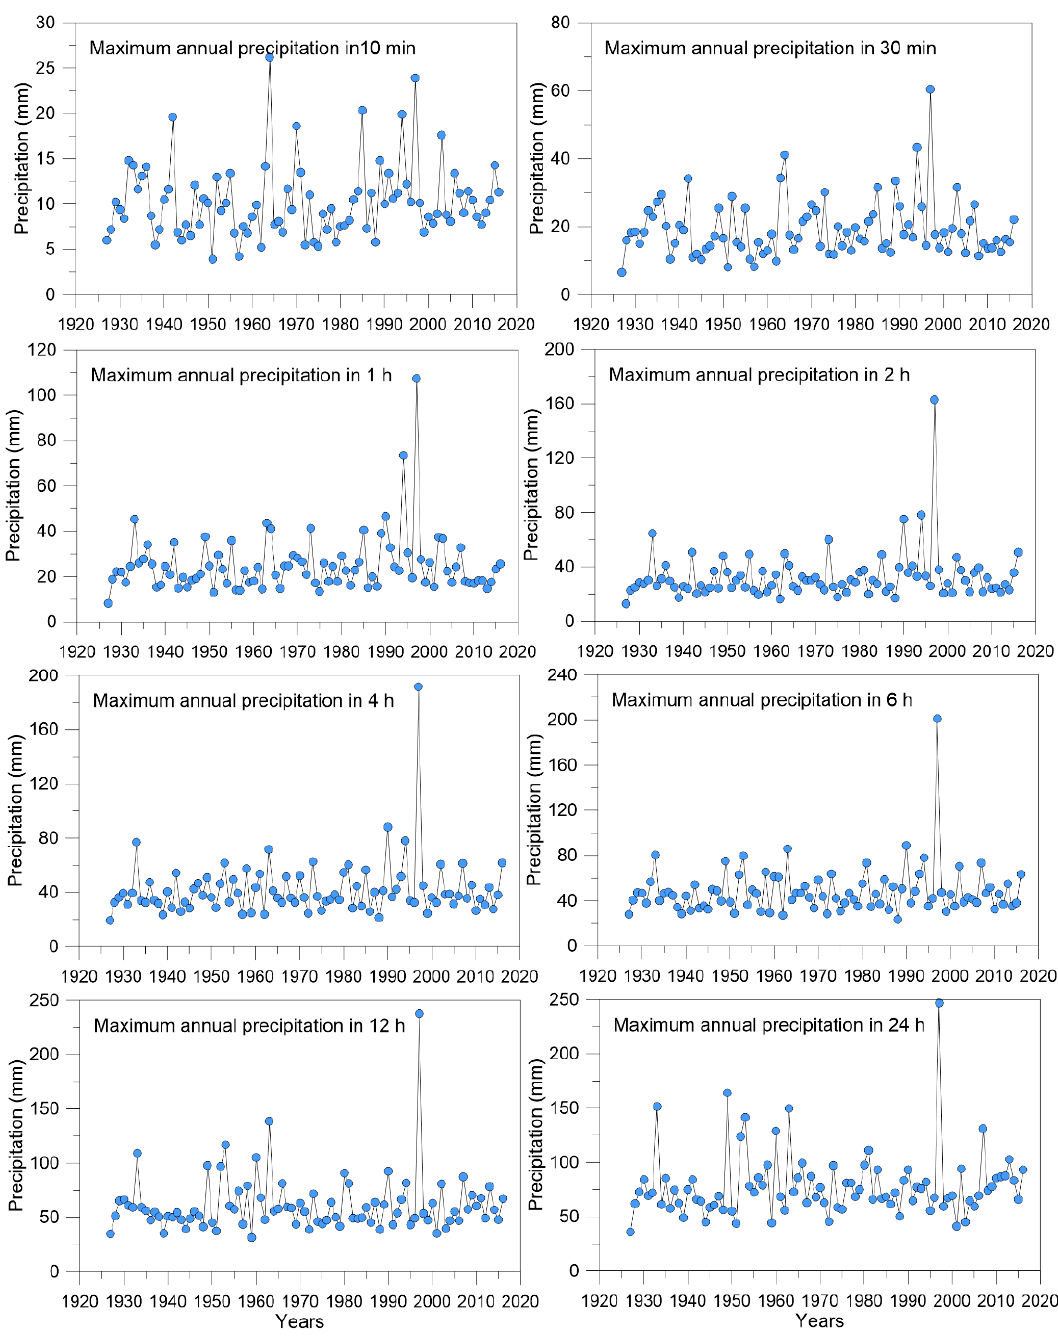
Figure 3. Representation of the di ff erent series of maximum annual precipitation